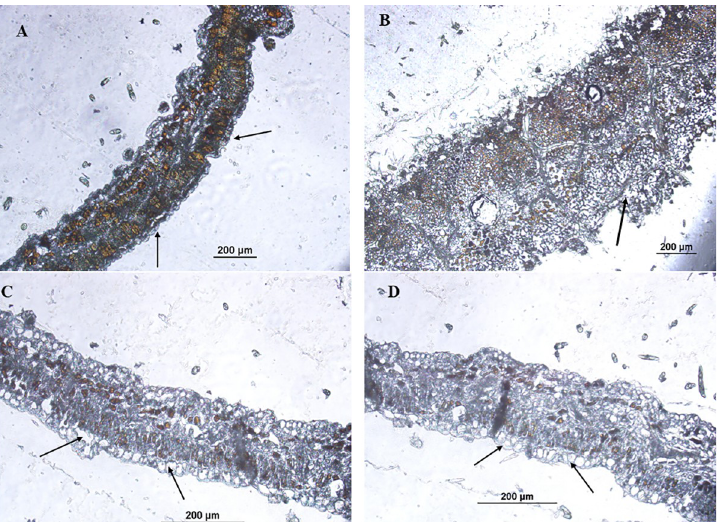
Fig 8. (A): Non-transgenic (control) Gossypium hirustum after wax removal. (B): Gossypium arboreum after wax removal (C): Transgenic Gossypium hirustum showing higher wax removal after treatment with the organic solvent. (D): Transgenic Gossypium hirustum showing higher wax removal after treatment with the organic solvent.